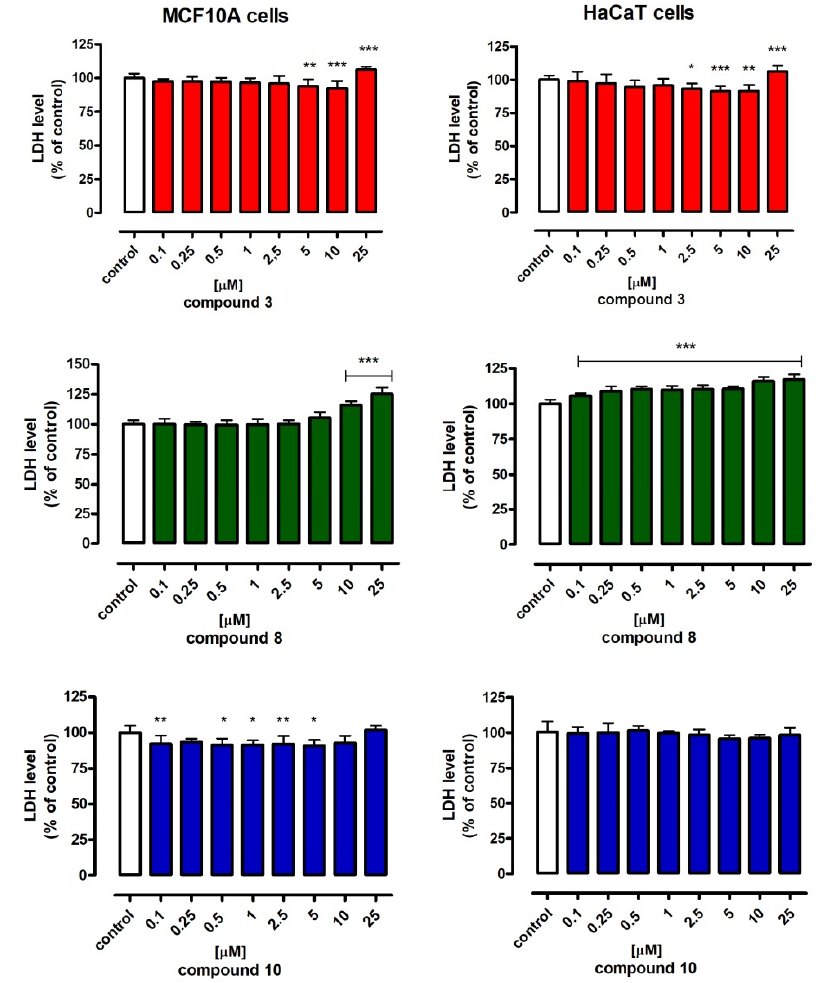
Figure 5. Influence of compounds 3 , 8 and 10 on viability of normal mammary gland MCF10A cells and normal keracinocytes HaCaT cells. Levels of lactic dehydrogenase (LDH) released from cells in the absence (control) and in the presence of tested compounds (0.1–25 µM) were quantified after 72-h treatment. Data represents mean normalized optical densities ± SEM of 4–6 trials, *** at least p < 0.001, ** p < 0.01, * p < 0.05 vs. control, one-way ANOVA test, post hoc Tukey.